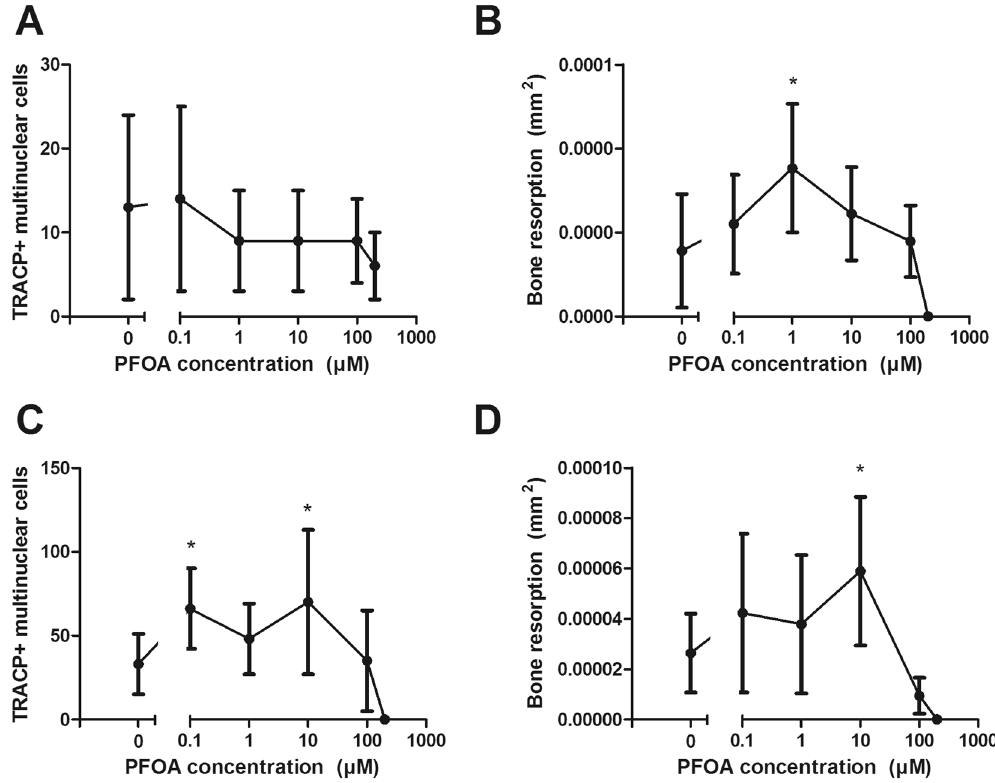
Figure 5. Effect of PFOA on the number of multinuclear TRACP + cells and resorption area in bone marrow ( A and B ) and peripheral blood derived osteoclasts ( C and D ) per bone slice after exposure for 10 days. Plots represent mean ± SD. * p <